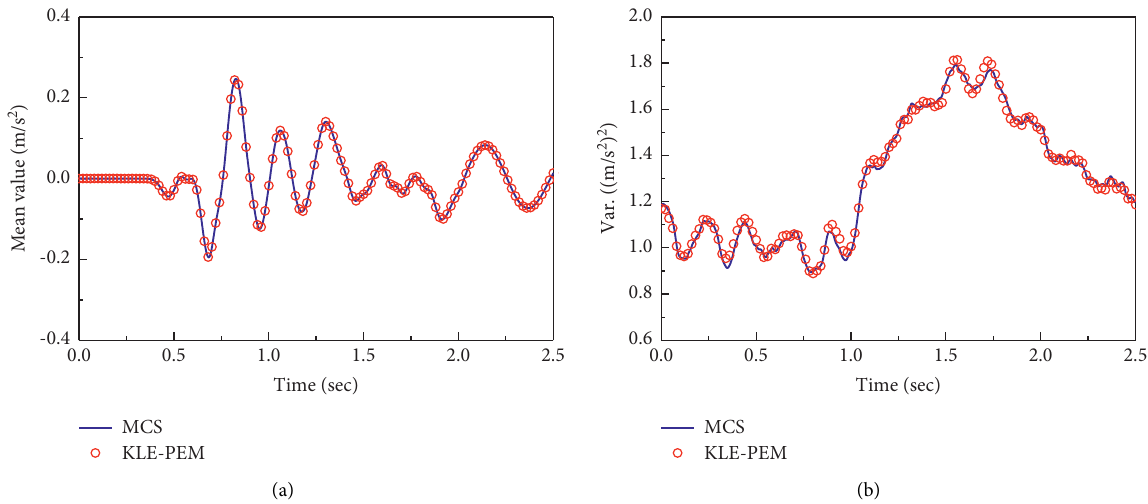
Figure 7: Comparison of the statistical moment of car body vertical acceleration of the two methods: (a) MEAN; (b) VAR.